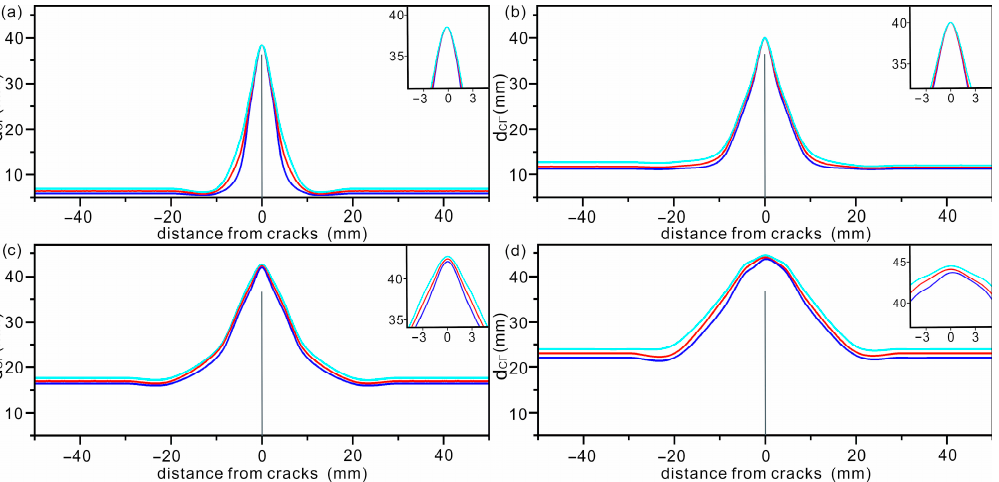
Figure 8. The outermost diffusion contours of chlorides in concrete with water–cement ratio of ( a ) 0.3, ( b ) 0.4, ( c ) 0.5 and ( d ) 0.6, respectively. AC is shown as a solid black line. Bright blue, red and blue represent data collected with degree of hydration of 0.8, 0.85 and 0.9, respectively.